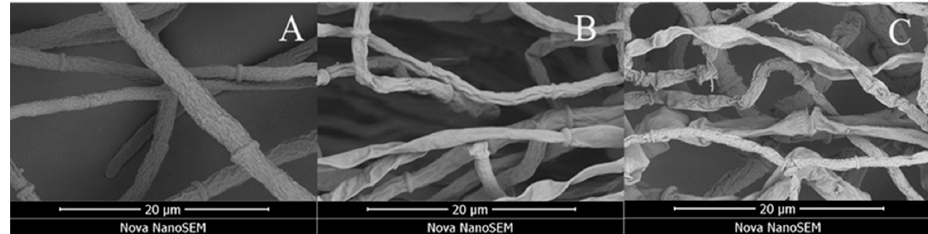
Figure 6. SEM images of the hyphae of S. sclerotiorum after treatment with different concentrations of W12 . ( A ) 0 μ g/mL, ( B ) 50 μ g/mL, and ( C ) 100 μ g/mL. Scale bar for ( A – C ) are 20 μ m. W12 . ( A ) 0 µ g/mL, ( B ) 50 µ g/mL, and ( C ) 100 µ g/mL. Scale bar for ( A – C ) are 20 µ